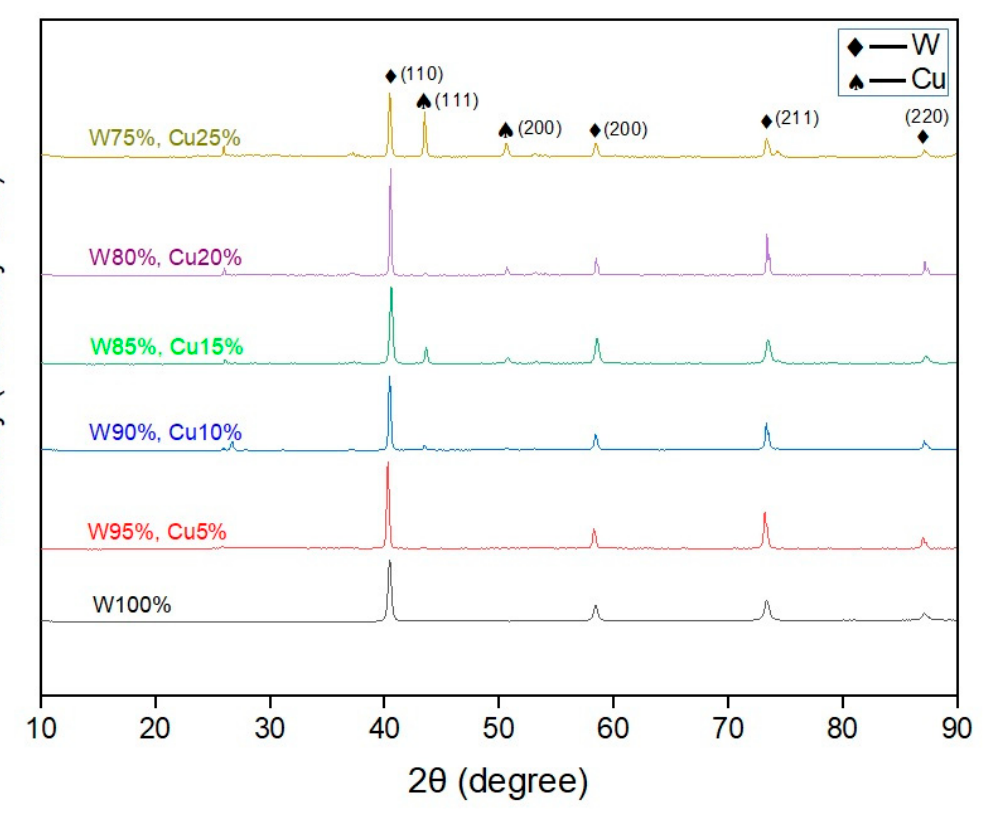
Figure 2. X-ray diffraction (XRD) profile of the sintered samples.